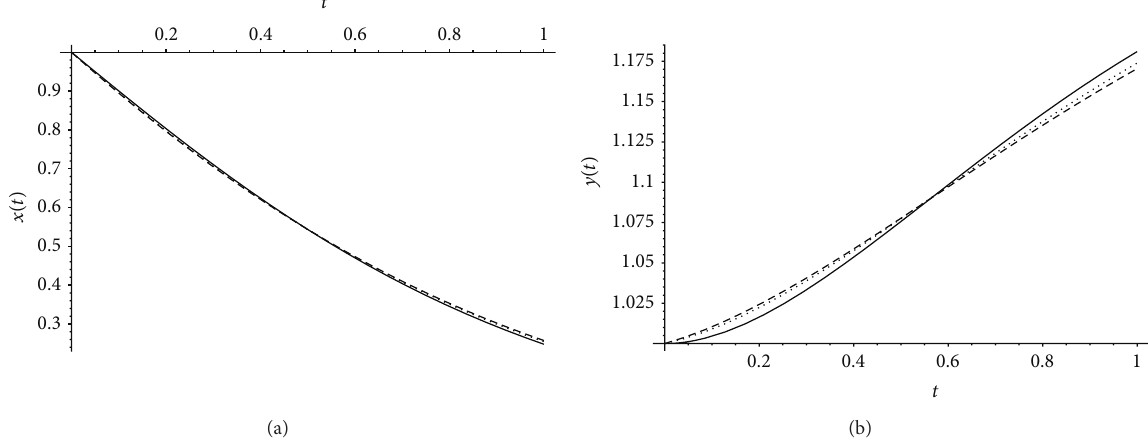
Figure 1: The exact solution (black line) and approximation solutions when 𝛼 = 1 , 𝛽 = 1 , and 𝑚 = 12 (dotted) and 𝑚 = 8 (dashed).